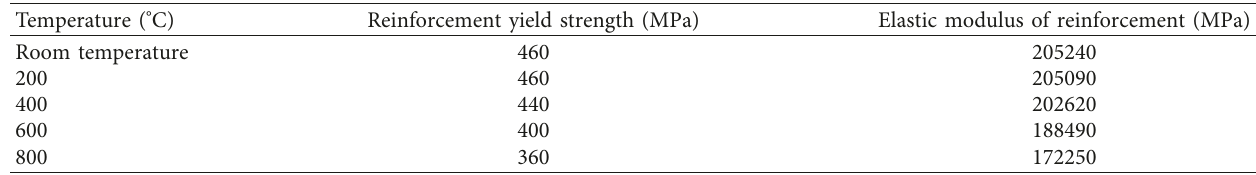
Table 5: Reinforcement parameters of coal gangue geopolymer concrete beams.